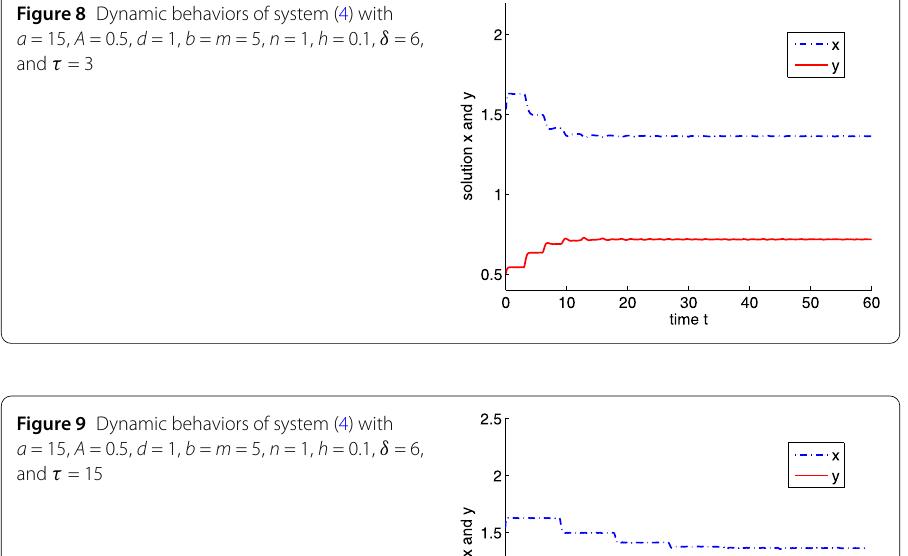
Figure 9 Dynamic behaviors of system (4) with a = 15, A = 0.5, d = 1, b = m = 5, n = 1, h = 0.1, δ = 6,